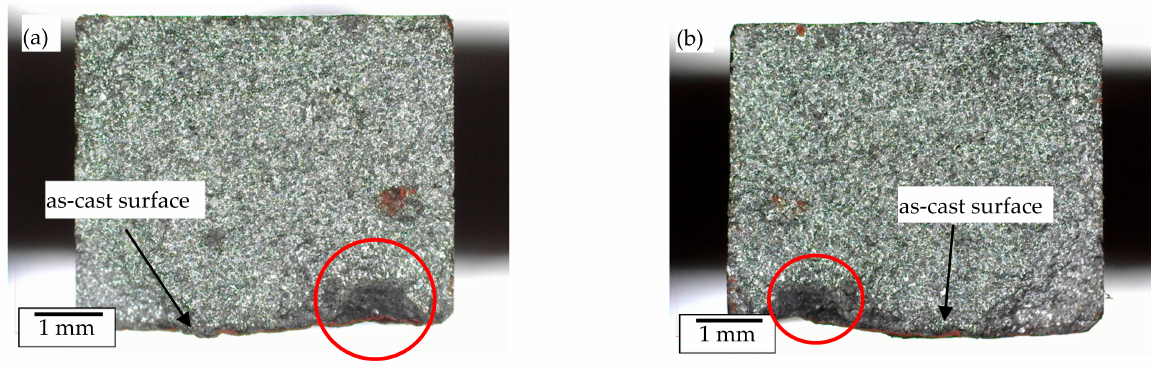
Figure 14. Fracture surfaces after strain-controlled fatigue tests of EN-GJS-450-10 plain specimens (Figures 5 and 6): ( a , b ) R ε = − 1, machined conditions, ( c , d ) R ε = − 1, as-cast conditions; ( e , f ) R ε = 0.1 and ( g , h ) R ε = 0.5 in the machined conditions.